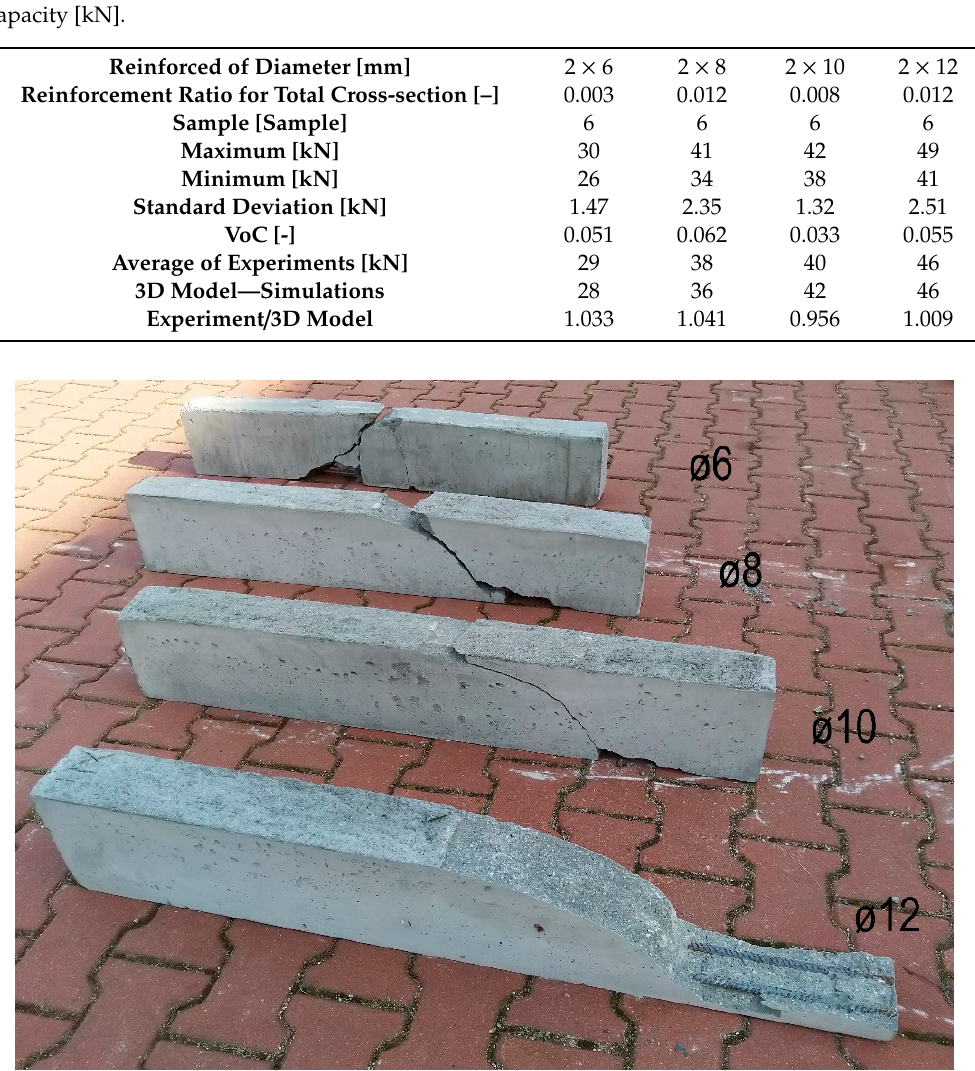
Figure 12. Reinforced concrete beams without transverse reinforcement after testing.